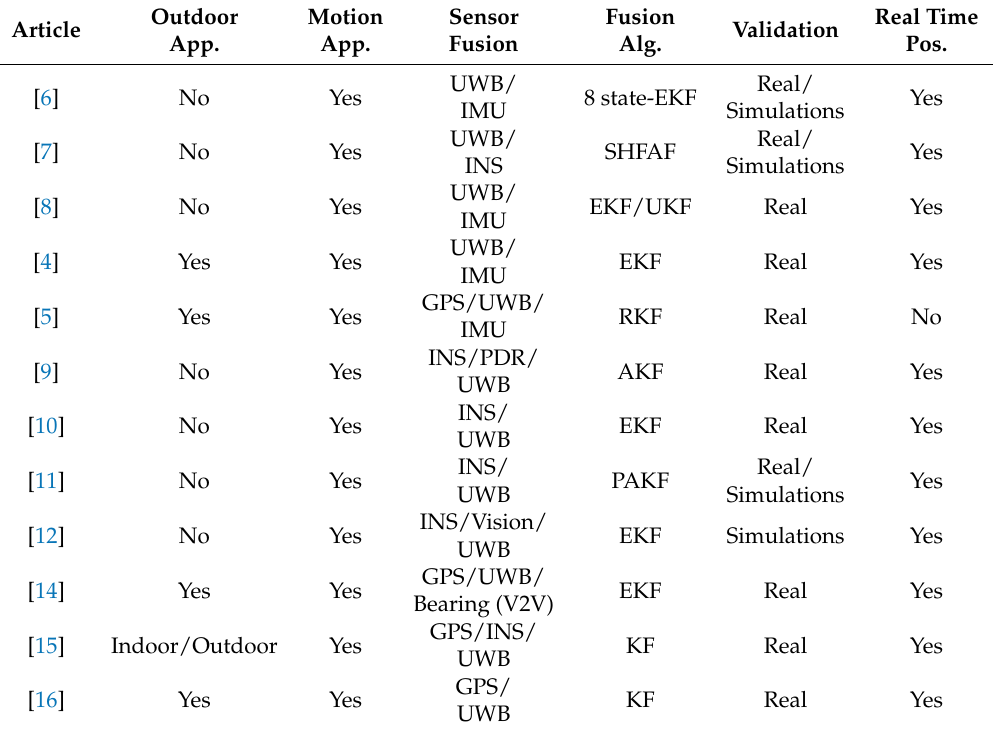
Summary of the main features of the related work that propose an UWB/INS positioning